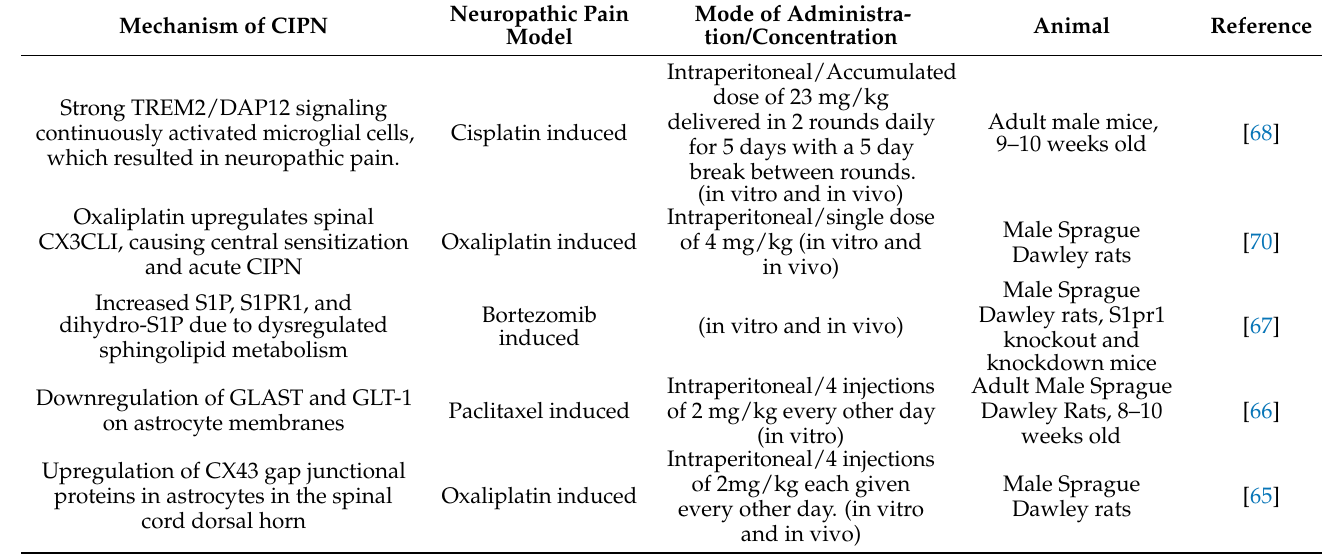
Table 5. Studies investigating the mechanisms by which anticancer drugs exert their effects. Neuropathic Pain Mode of Administra- Mechanism of CIPN Model tion/Concentration